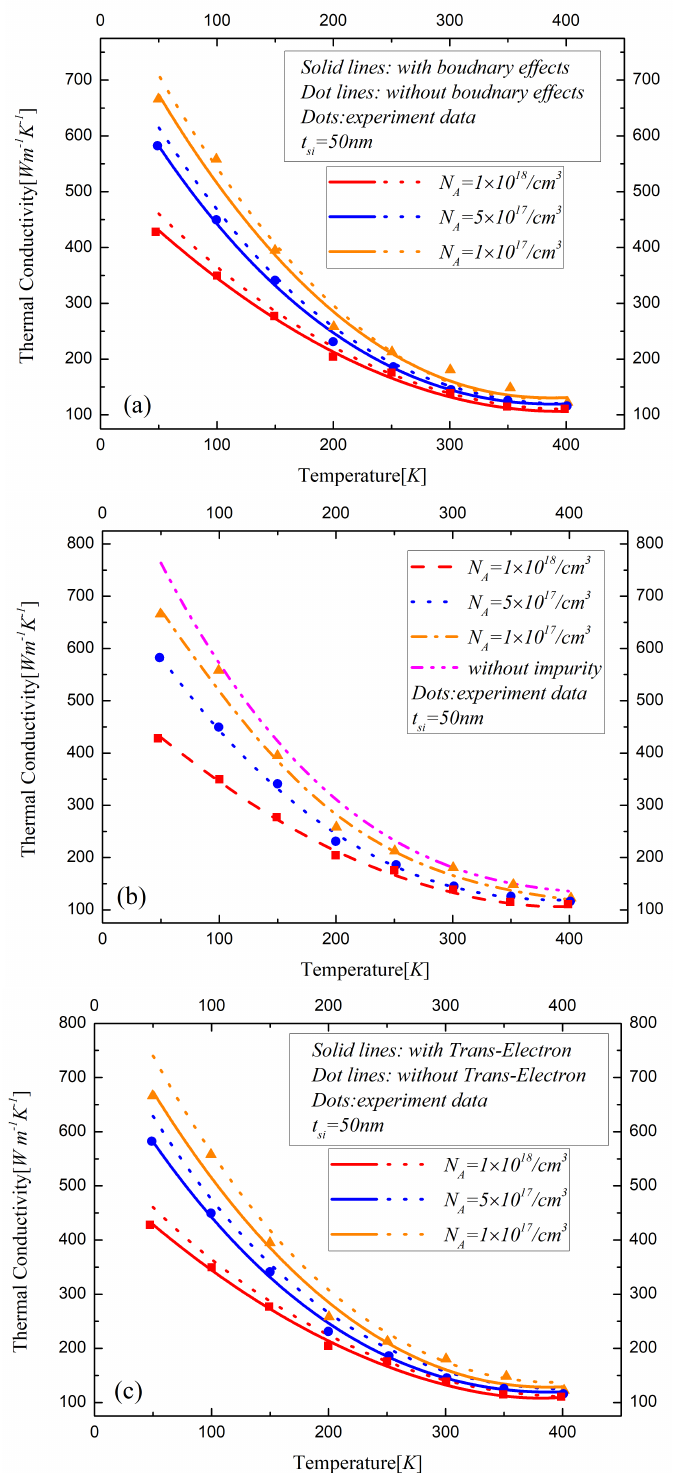
Figure 6. The influences of ( a ) boundary scattering effects, ( b ) impurity, ( c ) free and bound electron on the thermal conductivity of the 50 nm-thickness silicon film material in ultra-thin body FD-SOI